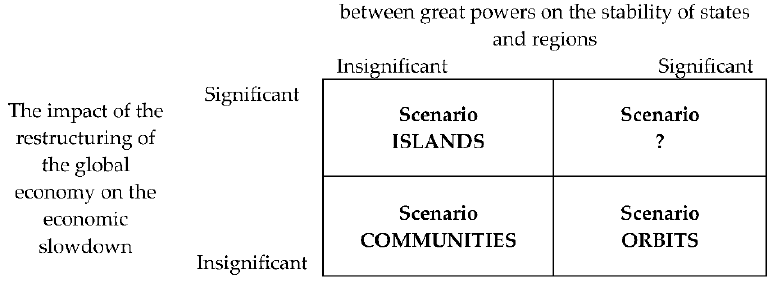
Figure 2. Scenario matrix. Source: [28] (pp. 46–61).